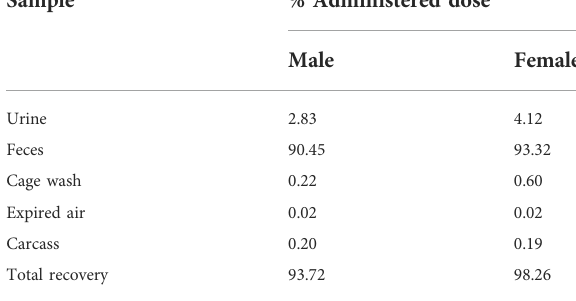
TABLE 4 Excretion of radioactivity during 0 – 168 h after